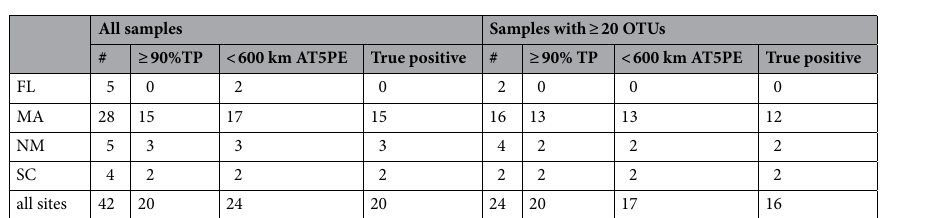
all Table 1. Attribution metrics for 14-day dust samples. Total number of 14-day dust samples, or the subset of 14-day dust samples with ≥ 20 OTU, that yielded a ≥ 90% TP, less than 600 km AT5PE, or true positive geographic attribution from analysis of constituent plant eDNA from samples collected at the sites indicated. A true positive attribution was defined ≥ 90% TP with < 600 km AT5PE.